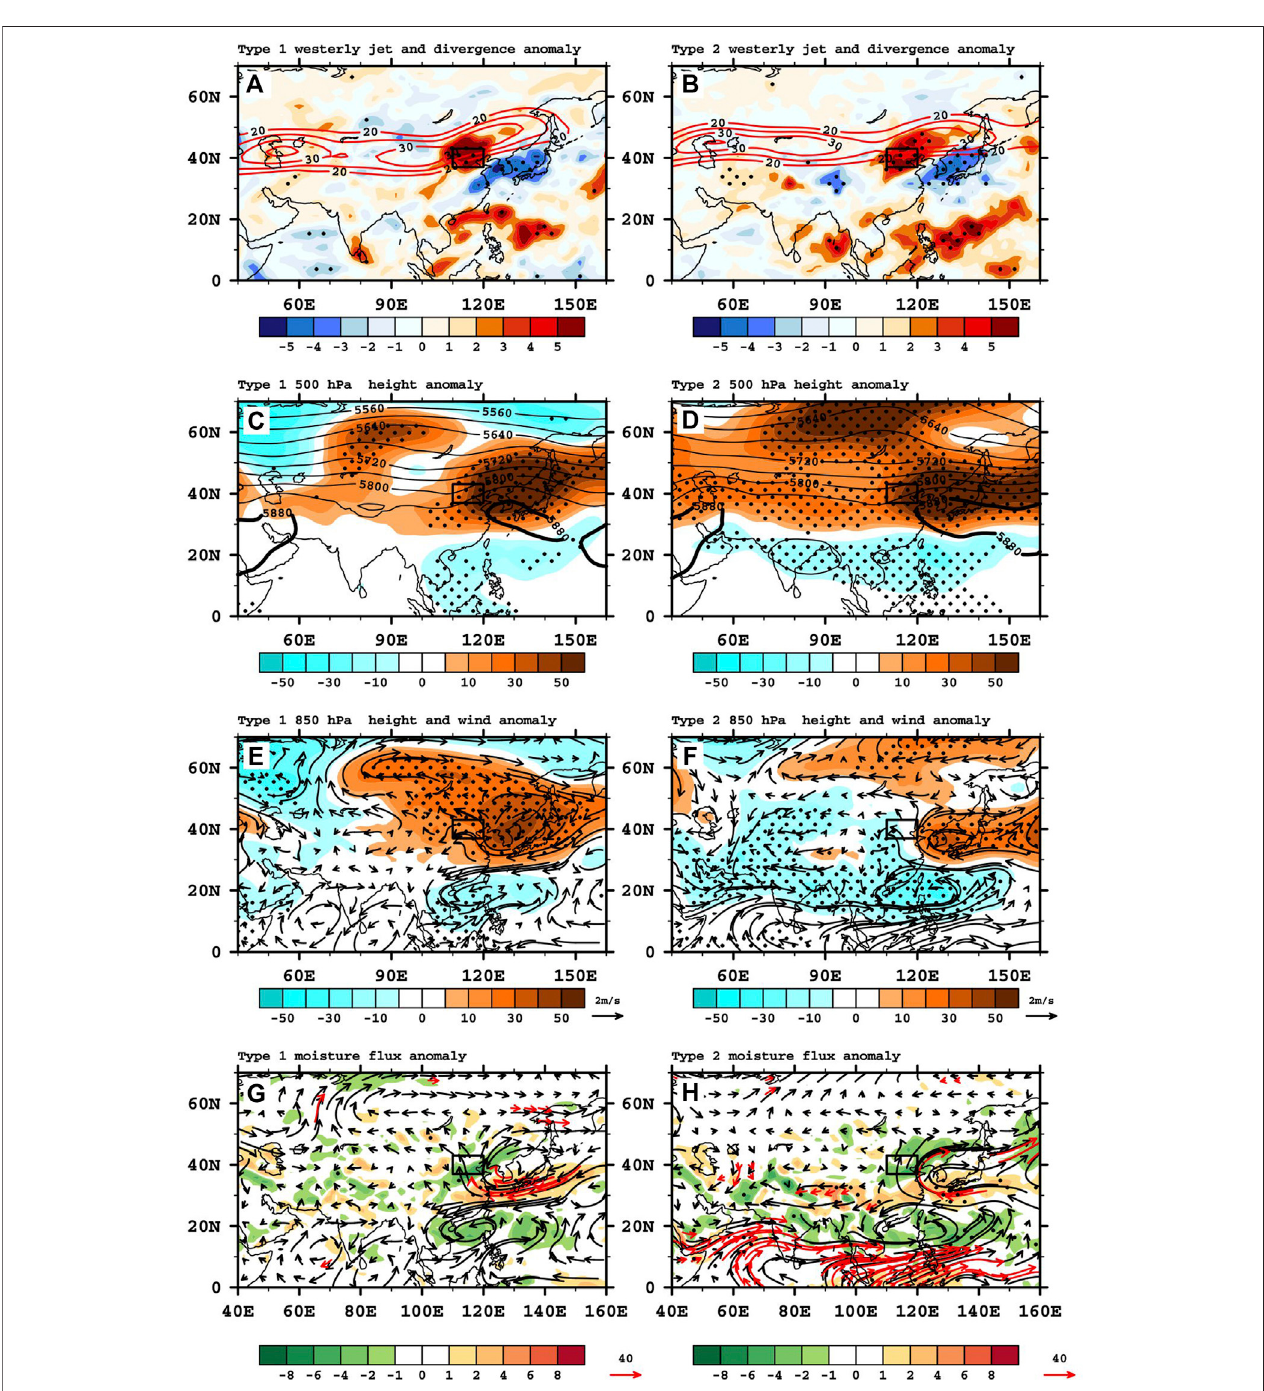
FIGURE 6 | Westerly jet (contour, unit: m · s-1) and divergence anomalies (shading, unit: 10-6s-1) at 200 hPa (A,B) , mean geopotential height (contour, unit: gpm) and height anomalies (shading, unit: gpm) at 500 (C,D) and 850 hPa (E,F) , vertically integrated moisture fl ux anomalies (shading, unit: 10-5kg/m2/s) and moisture fl ux divergence anomalies (black vector, unit: kg/m/s) from 1,000 to 300 hPa (G,H) of type 1 and type 2 PEPEs. Dotted areas and red vectors in (G,H) indicate a 95% con fi dence level. Rectangle indicates North China.